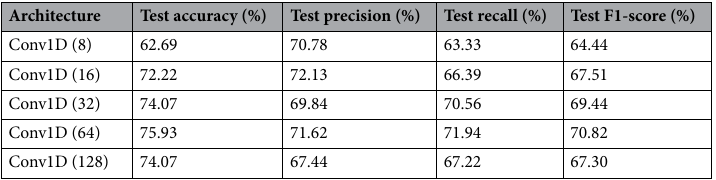
Table 2. Performance of 1D CNN with a single convolution layer according to different number of channels from 8 to 128.